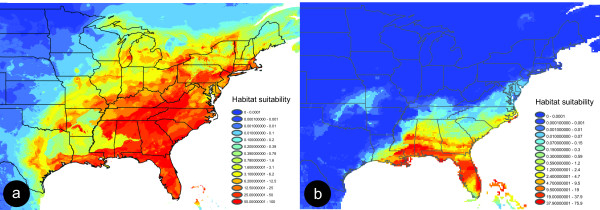
Niche-based distribution model constructed in MAXENT using current and Pleistocene climatic parameters for Narceus. The models show the predicted distribution (habitat suitability) of Narceus during (a) the present and (b) the Last Glacial Maximum. Distribution models illustrate high levels of predicted habitat suitability in red and low levels in blue.